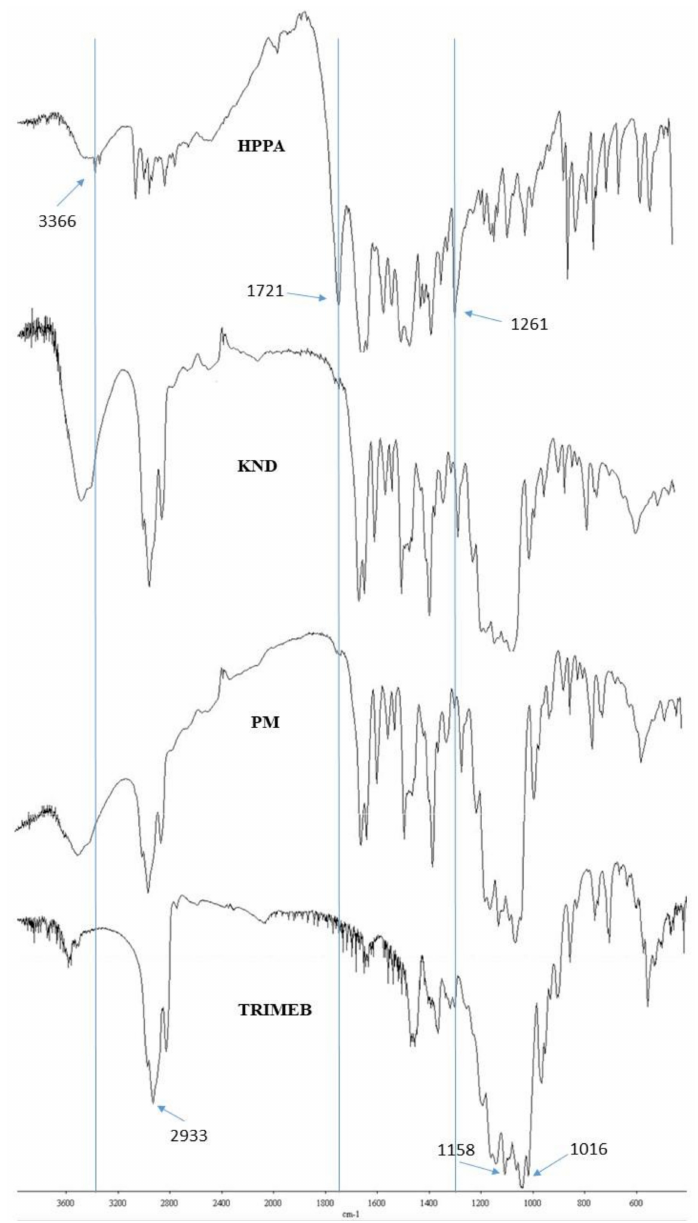
Figure 2. FT-IR spectra of TRIMEB, the kneading product (KND), the physical mixing product (PM), and